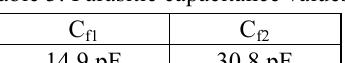
and X ) are N N and X with frequency for two N N